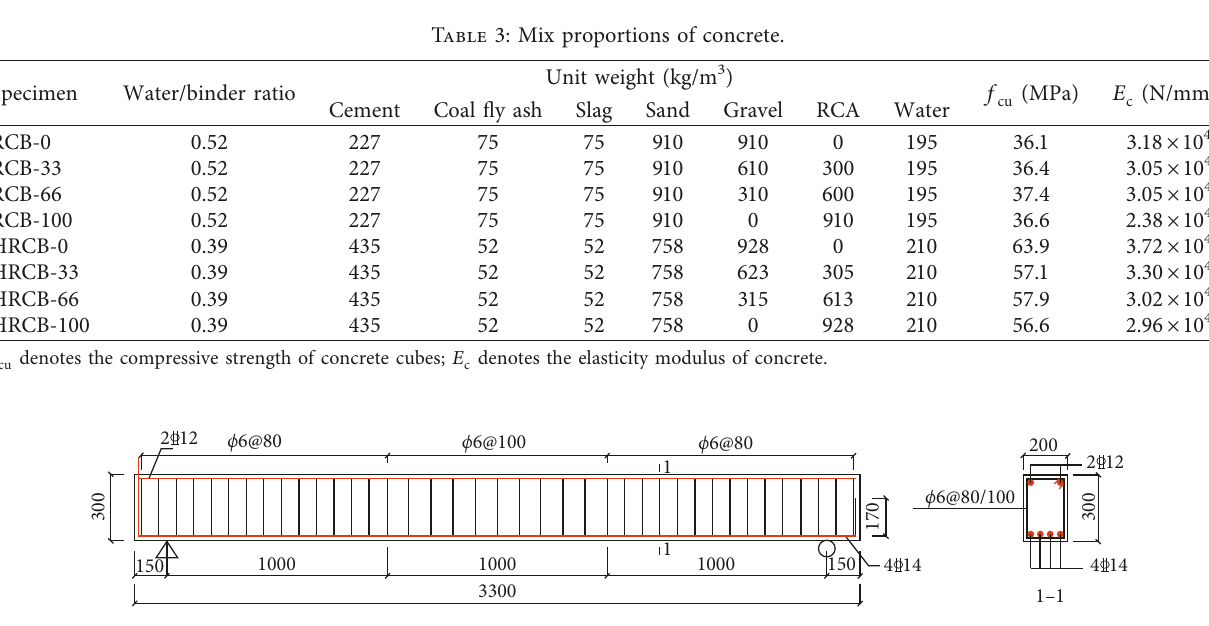
Figure 2: Specimen size and reinforcement details (unit: mm).